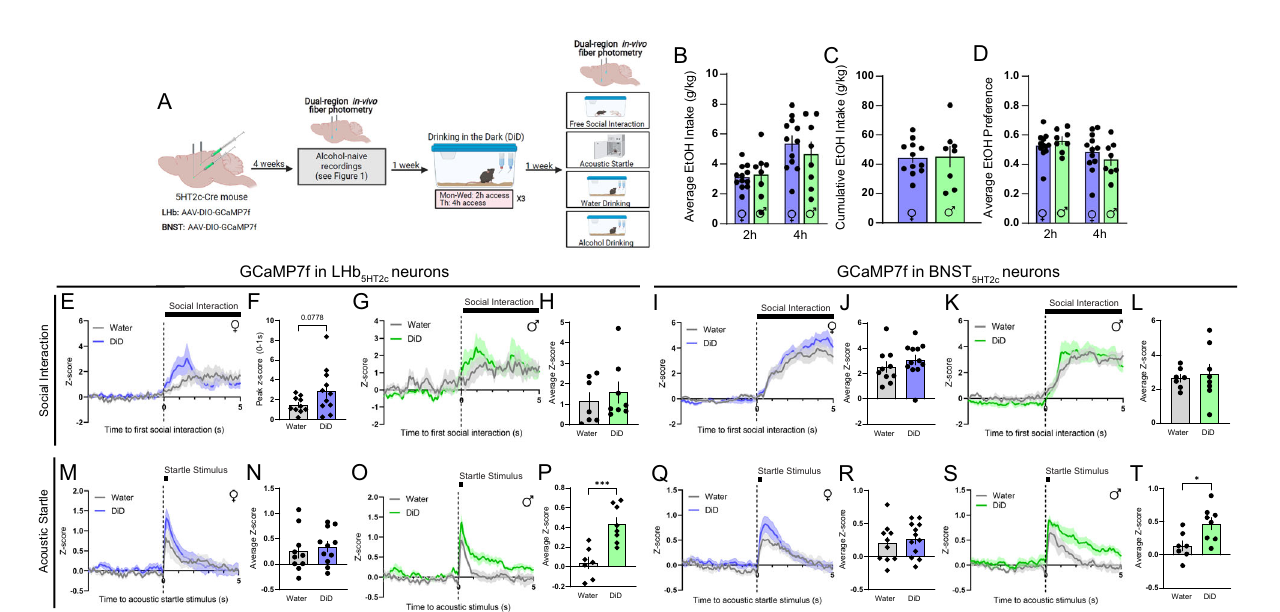
Fig. 7 | DiD modulates the calcium responses of LHb 5HT2c and BNST 5HT2c neu- mice/1 trial, DiD n =8 mice/1 trial). M Peri-event plot of LHb 5HT2c GCaMP activity rons to affective stimuli. A Surgical schematic and experimental timeline for duringtheacousticstartletest,females(water n =10mice/10trials,DiD n =11mice/ LHb 5HT2c and BNST 5HT2c GCaMP fi ber photometry experiments in DiD-exposed 10trials). N Averagez-scoreofLHb 5HT2c GCaMPsignalfor0 – 5spostacousticstartle mice. B Average alcohol consumption in DiD ( n =12 females, n =8 males). stimulus,females(water n =10mice/10trials,DiD n =11mice/10trials). O Peri-event C Cumulative alcohol intake in DiD( n =12 females, n =8 males). D Average alcohol plot of LHb 5HT2c GCaMP activity during the acoustic startle test, males (water n =7 mice/10trials,DiD n =8mice/10trials). P Averagez-scoreofLHb 5HT2c GCaMPsignal preferenceinDiD( n =12females, n =8males). E Peri-eventplotofLHb 5HT2c GCaMP activity during the fi rst interaction with a novel social target, females (water n =10 for 0 – 5s post acoustic startle stimulus, males, p =0.0008 (water n =7 mice/10 mice/1 trial, DiD n =11 mice/1 trial). F Peak z-score of LHb 5HT2c GCaMP signal for trials, DiD n =8 mice/10 trials). Q Peri-event plot of BNST 5HT2c GCaMP activity 0 – 1spostinteraction,females,Mann – Whitney U test(water n =10mice/1trial,DiD duringtheacousticstartletest,females(water n =10mice/10trials,DiD n =12mice/ fi rst n =11 mice/1 trial). G Peri-event plot of LHb 10 trials). R Average z-score of BNST 5HT2c GCaMP signal for 0 – 5s post acoustic 5HT2c GCaMP activity during the interactionwithanovelsocialtarget,males(water n =7mice/1trial,DiD n =8mice/ startle stimulus, females (water n =10 mice/10 trials, DiD n =12 mice/10 trials). S Peri-eventplotofBNST 5HT2c GCaMPactivityduringtheacousticstartletest,males 1 trial). H Average z-score of LHb 5HT2c GCaMP signal for 0 – 5s post interaction, males(water n =7mice/1trial,DiD n =8mice/1trial). I Peri-event plot of BNST 5HT2c (water n =7mice/10trials,DiD n =8mice/10trials). T Averagez-scoreofBNST 5HT2c GCaMPactivityduringthe fi rstinteractionwithanovelsocialtarget,females(water GCaMPsignalfor0 – 5spostacousticstartlestimulus,males, p =0.0157(water n =7 n =10 mice/1 trial, DiD n =12 mice/1 trial). J Average z-score of BNST mice/10 trials, DiD n =8 mice/10 trials). Unless otherwise stated, statistical com- 5HT2c GCaMP signalfor0 – 5spostinteraction,females(water n =10mice/1trial,DiD n =12mice/1 parisons were performed using two-way Student ’ s unpaired t tests. All data repre- trial). K Peri-eventplotofBNST 5HT2c GCaMPactivityduringthe fi rstinteractionwith sentedasmean±SEM.* p <0.05,** p <0.01,*** p <0.0001.Sourcedataareprovided anovelsocialtarget,males(water n =7mice/1trial,DiDn=8mice/1trial). L Average as a Source Data fi le. Created with z-score of BNST 5HT2c GCaMP signal for 0 – 5s post interaction, males (water n =7